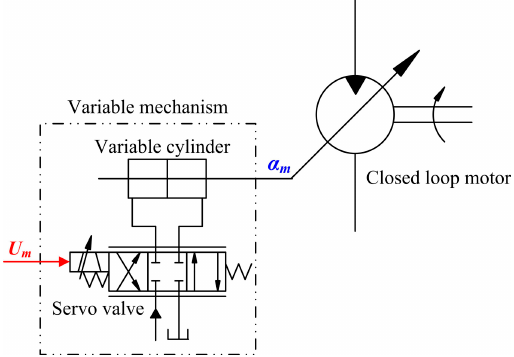
Figure 5. The schematic diagram of the variable motor.